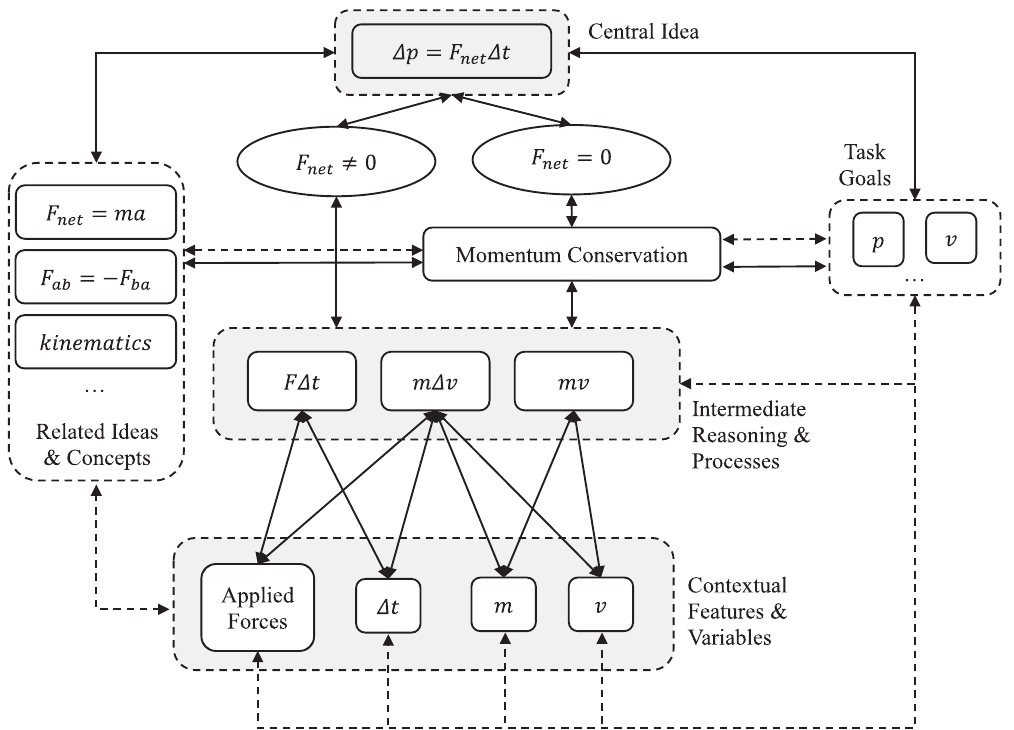
FIG. 1. Conceptual framework of momentum. Solid arrows represent experts ’ conceptual pathway, while the dashed lines represent the direct links between contextual features and the task outcomes that novices often